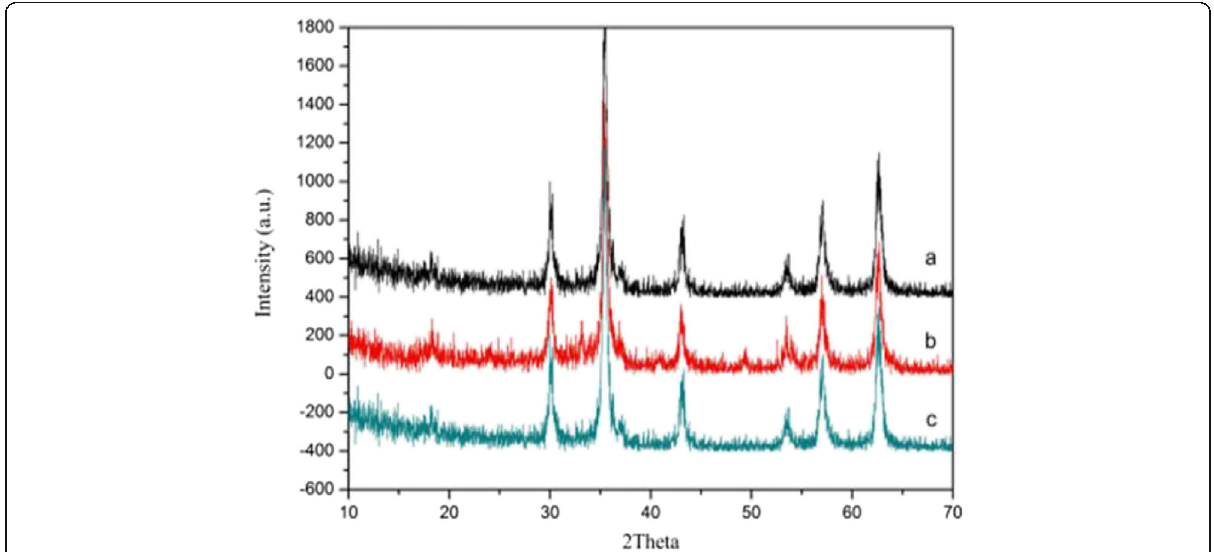
Fig. 7 XRD pattern of different amount of PAM synthesized sample. a 0.1 g. b 0.2 g. c 0.3